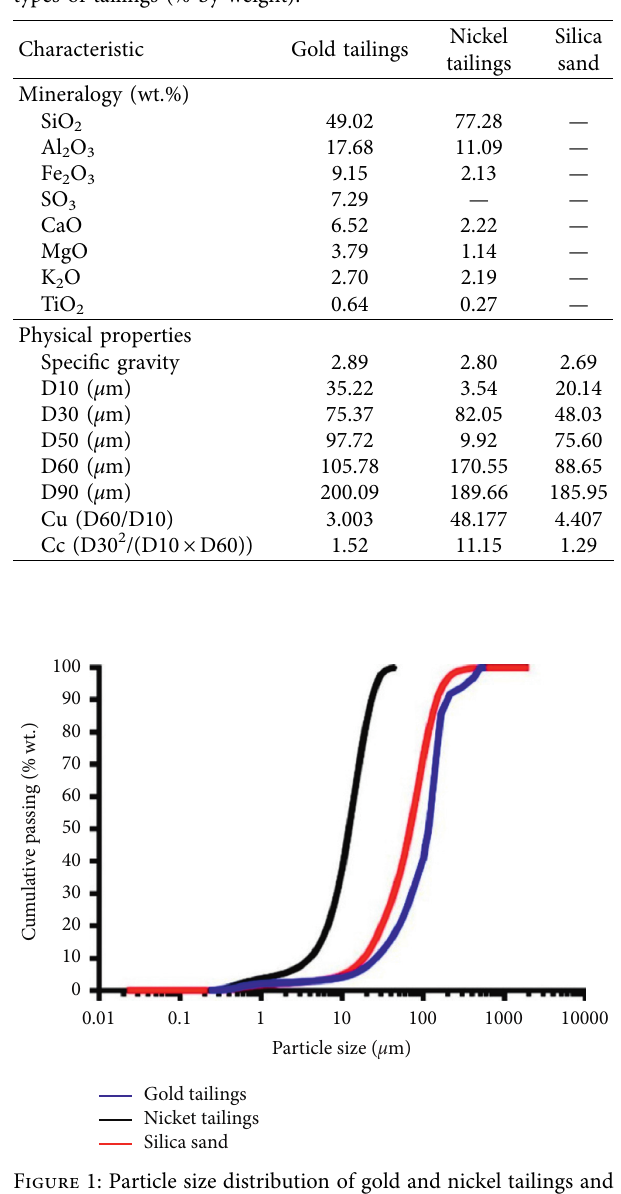
Table 1: Mineralogy and physical properties of silica sand and two types of tailings (% by weight).